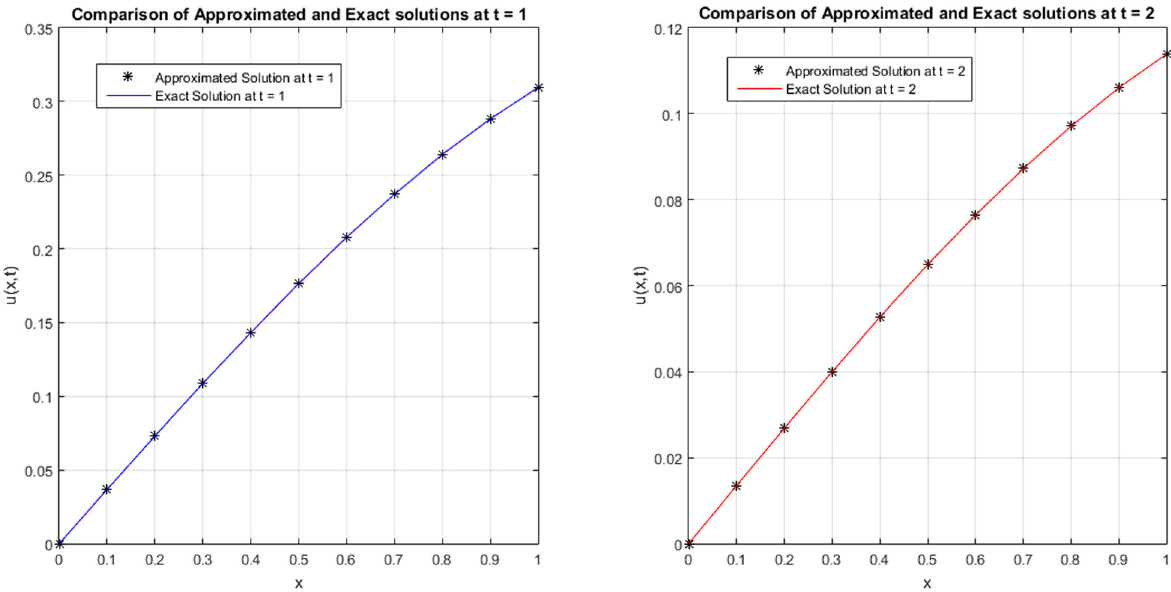
Figure 1: Comparison of approximated and exact ϕ ( η 1 , t ) at t = 1 and t = 2 for N = 11 regarding Example